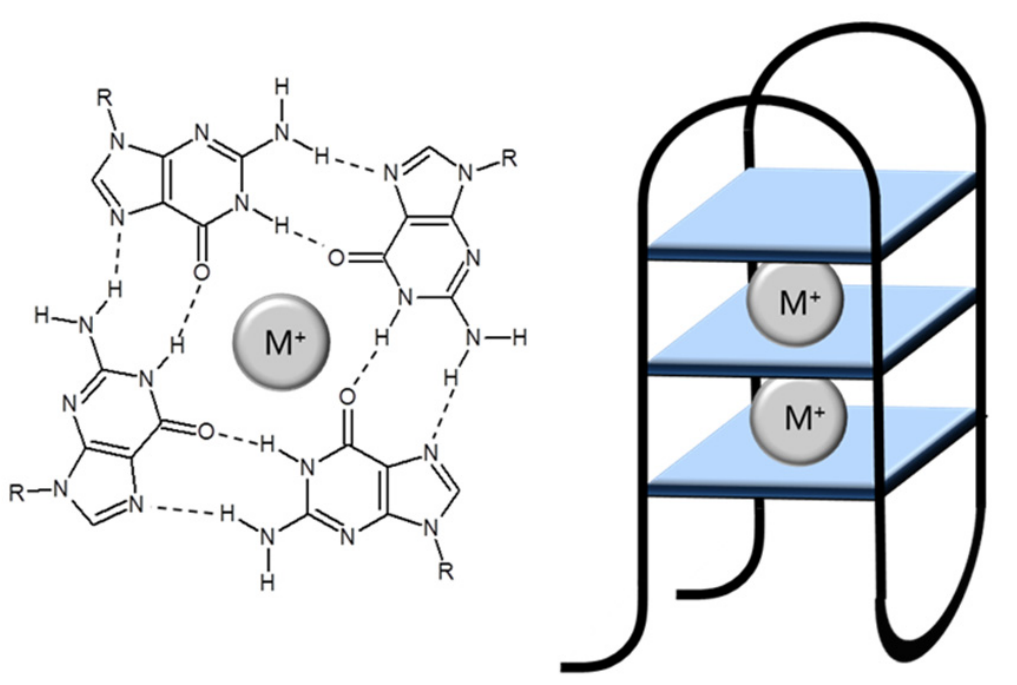
Figure 1. Left: structure of a G-quartet, with four guanines arranged around a central monovalent cation (M + ). Right: structure of a G-quadruplex, in this example an antiparallel unimolecular structure with three stacked quartets. Adopted and modified according to Huppert et al.